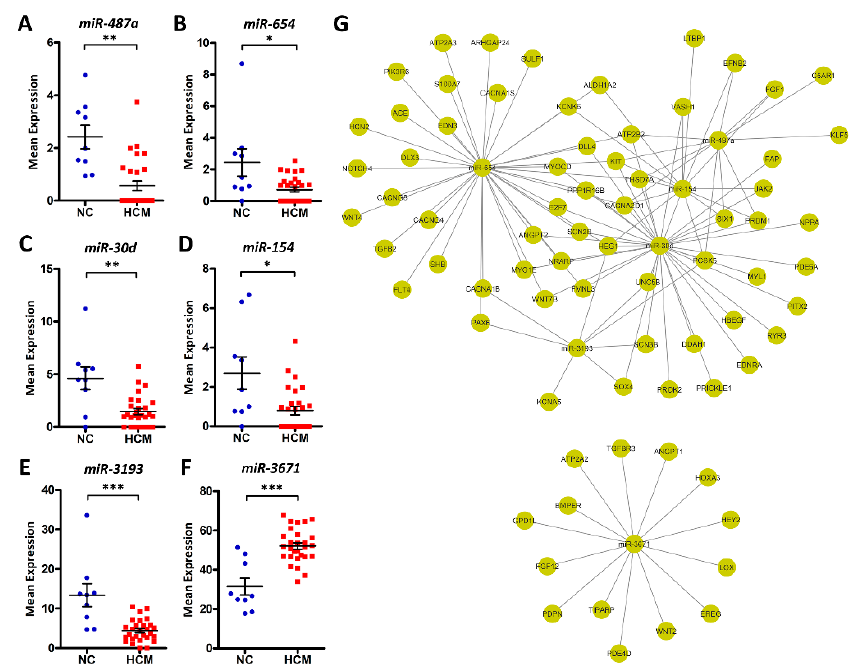
Figure 5. Differentially expressed microRNAs (miRNAs) between HCM patients and normal controls. ( A – F ) Dot plots of miR-487a , miR-654 , miR-30d , miR-154 , miR-3193 , and miR-3671 expression levels in NC and HCM patients, *FDR < 0.05, **FDR < 0.01, ***FDR < 0.001. ( G ) Predicted miRNA-gene pairs